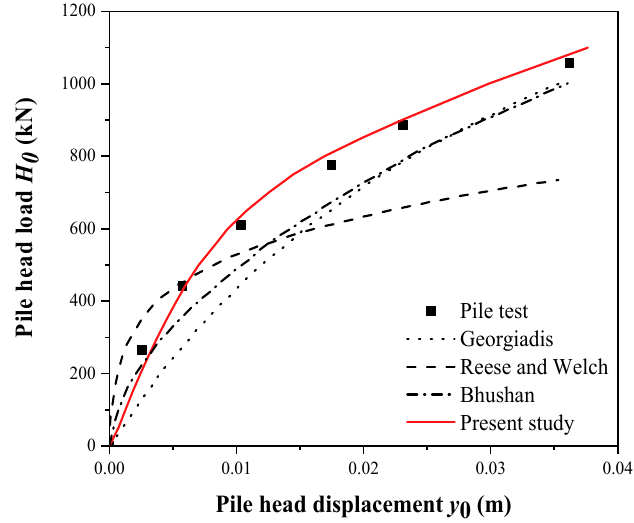
Figure 21. Validation with rigid pile test at the stiffness clay slope crest